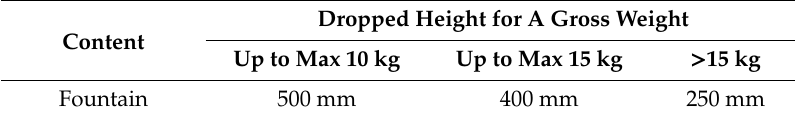
Figure 5. Sequence of the impact points in dropping test. Table 6. Dropped height for a gross weight.